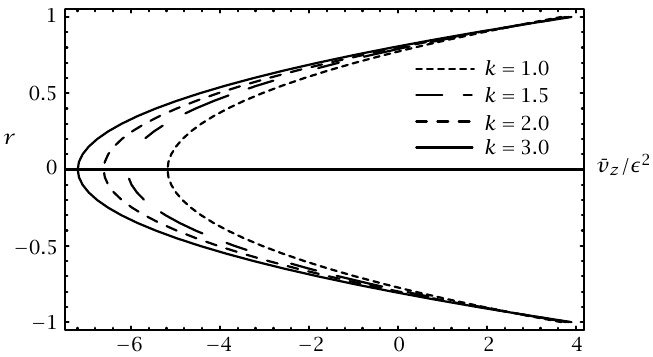
Figure 6.5 . The effect of the permeability parameter k on the mean-velocity distribution and reversal flow at Re = 10 . 0, (∂P/∂z) 2 = − 5, and α = 0 . 1.